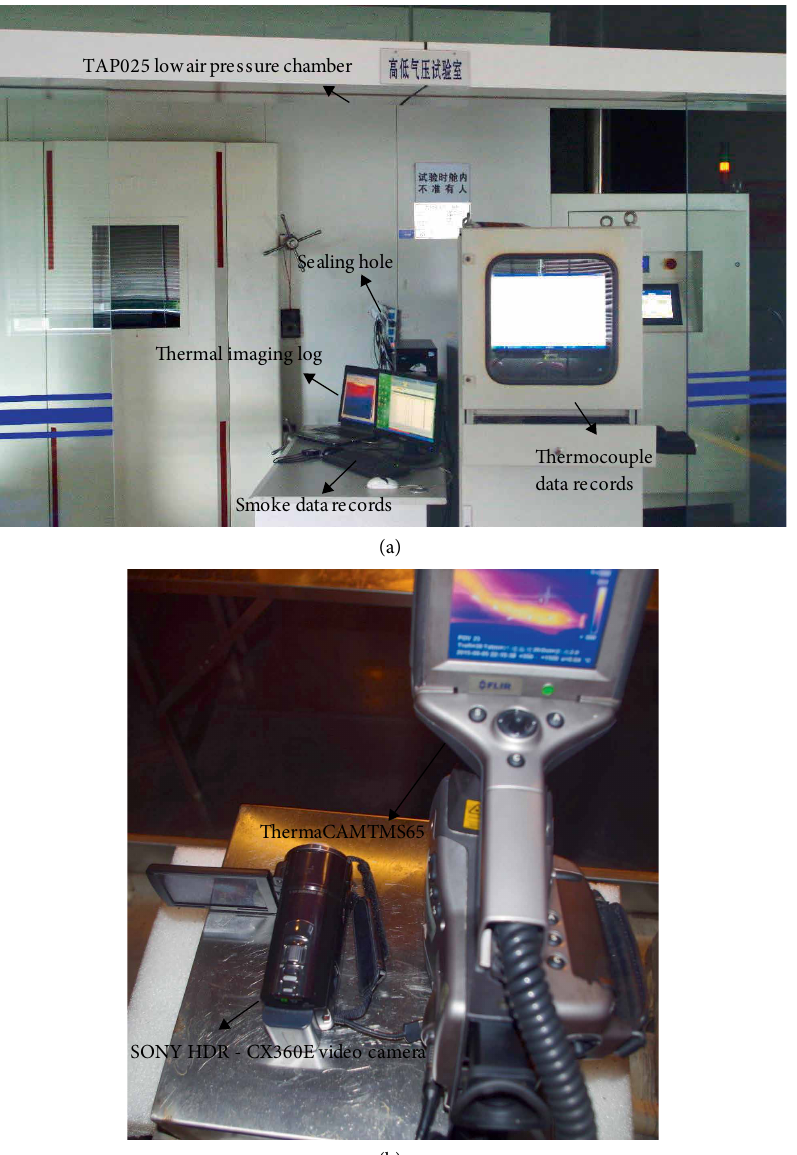
Figure 3: Physical diagram of main experimental equipment: (a) low-pressure test chamber and external apparatus, (b) flame measuring instruments in a low-pressure test